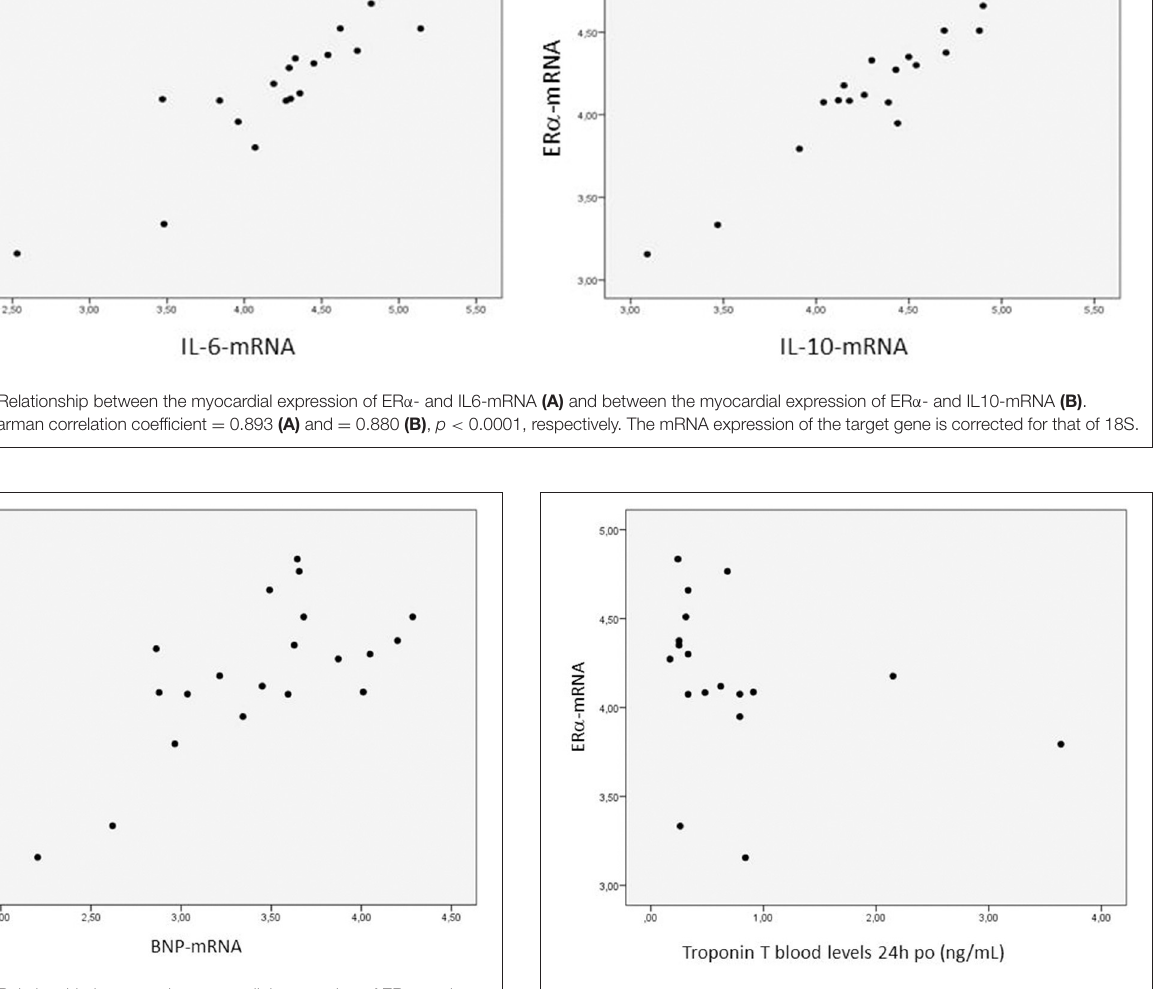
FIGURE 3 | Relationship between the myocardial expression of ER α -mRNA and troponin T blood levels 24h post-operatively. N = 18. Spearman correlation coefficient: − 0.505, p = 0.032. The expression of mRNA of the target gene is corrected for that of